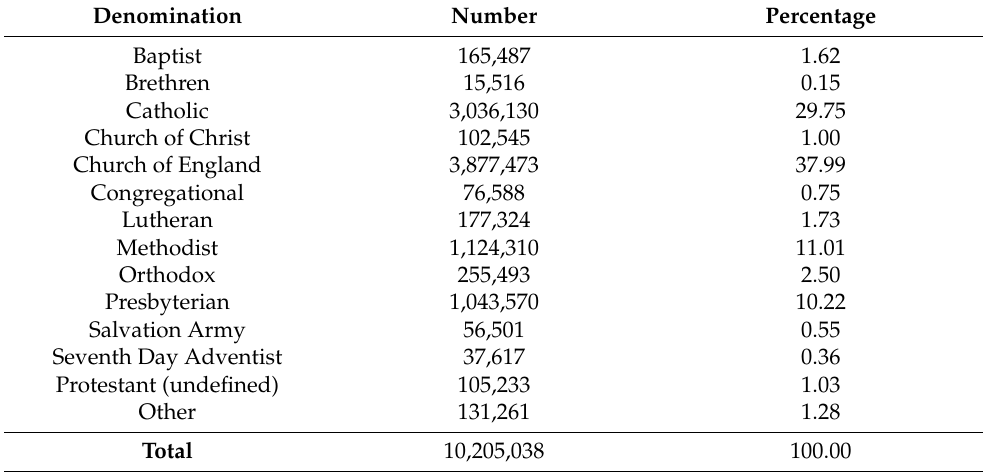
Table 1. Australian Christian Adherents